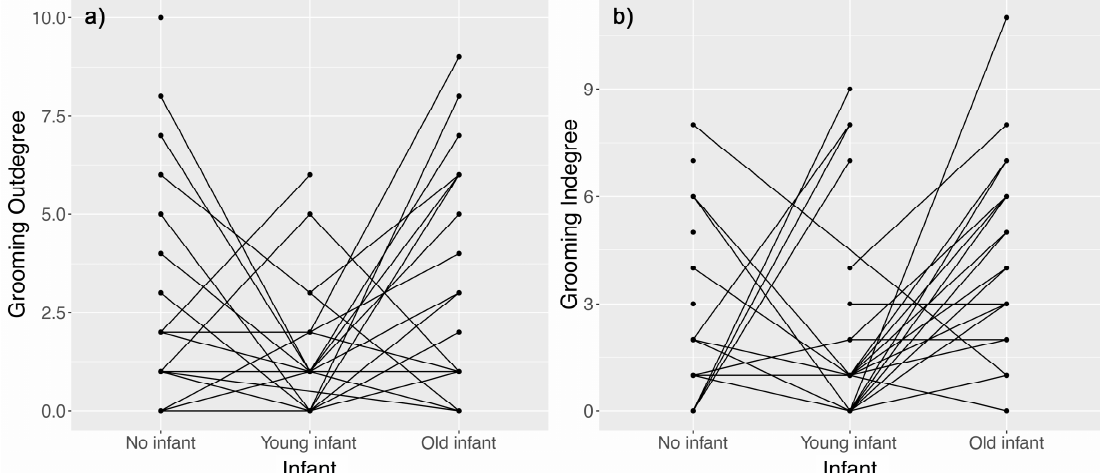
Figure 2. Comparison of the number of female partners ( a ) receiving (out-degree) or ( b ) giving (in-degree) grooming interactions across nursing condition (NN vs. YI vs. OI females). The lines represent the same individual experiencing different nursing conditions during the course of the study. Because several individual data points could overlap, more than two lines could start from the same dot.